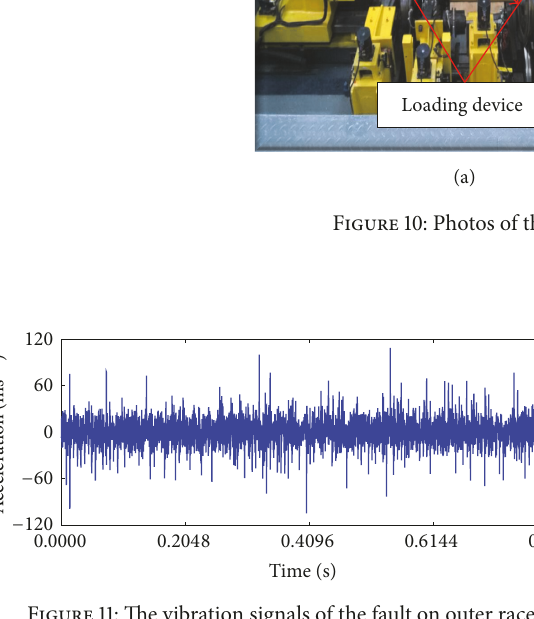
Figure 11: The vibration signals of the fault on outer